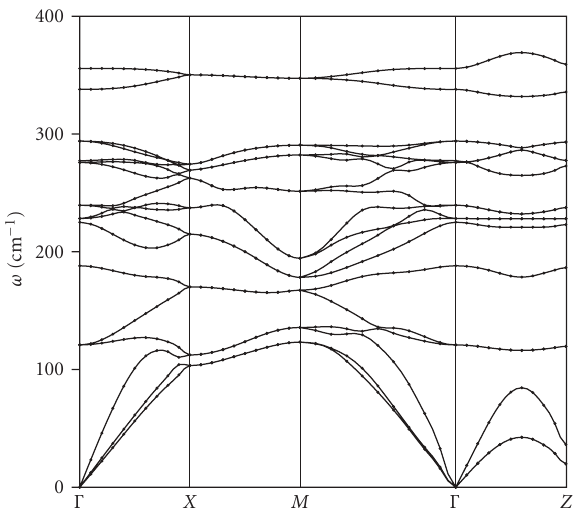
Figure 2: Density of states (DOSs) in NaFeAs. Both the total and atomic DOSs are shown. The Fermi energy is the zero energy. Near the Fermi energy, the DOS is dominated by the Fe 3d states.